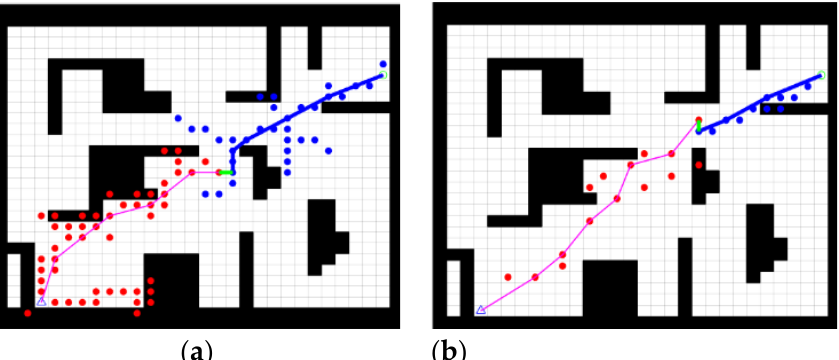
Figure 7. Comparison of two algorithms in obstacle-strewn environment. ( a ) Traditional bidirectional RRT* algorithm, ( b ) Improved bidirectional RRT* algorithm.